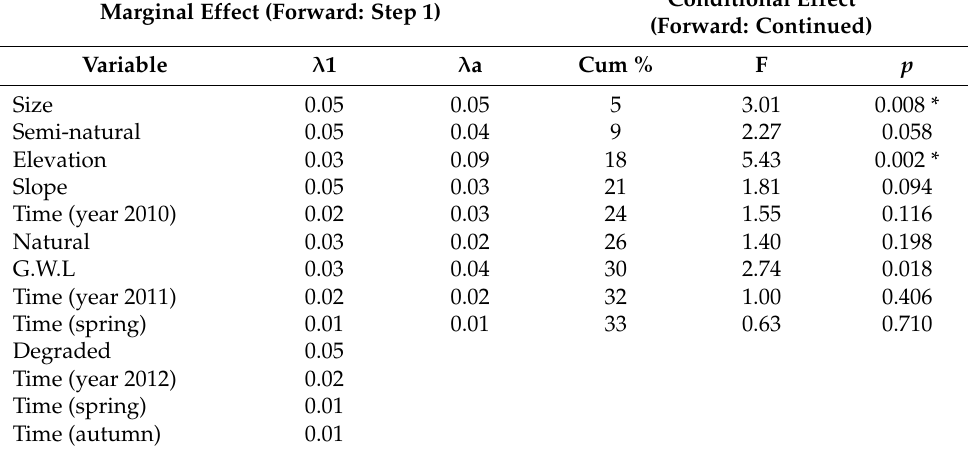
Table 5. Ranking environmental variables by importance according to marginal and condi- tional effects on the Lumbricidae community taxonomic composition variability in the moun- tain fen Caltho-Alnetum sites by automatic forward selection in RDA. RDA model calculated with log 10 (x + 1)-transformed species data. λ 1 = fit = eigenvalue with only one variable; λ a = additional fit = increase in eigenvalue; cum %—explained cumulative % of eigenvalues; F—value of the F-ratio statistic; p —significance level of the conditional effect tested by unrestricted Monte Carlo permutation test under the reduced model with 499 permutations; G.W.L.—groundwater